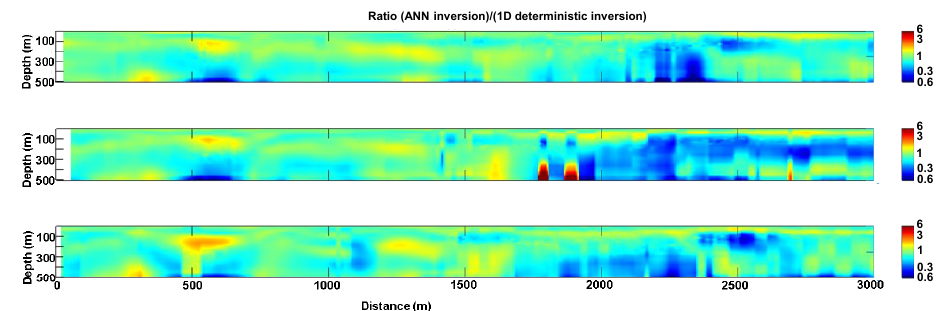
Figure 8. The ratio between the conductivity models in Figure 6 (the ANN inversion result) and in Figure 7 (the deterministic inversion